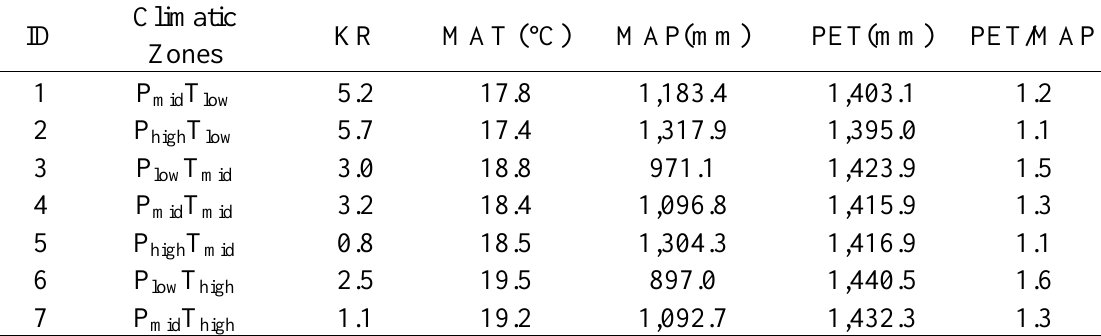
Table 2. Sub-zone averages of healthy:unhealthy koa ratios (KR) and environmental variables per climatic zone.